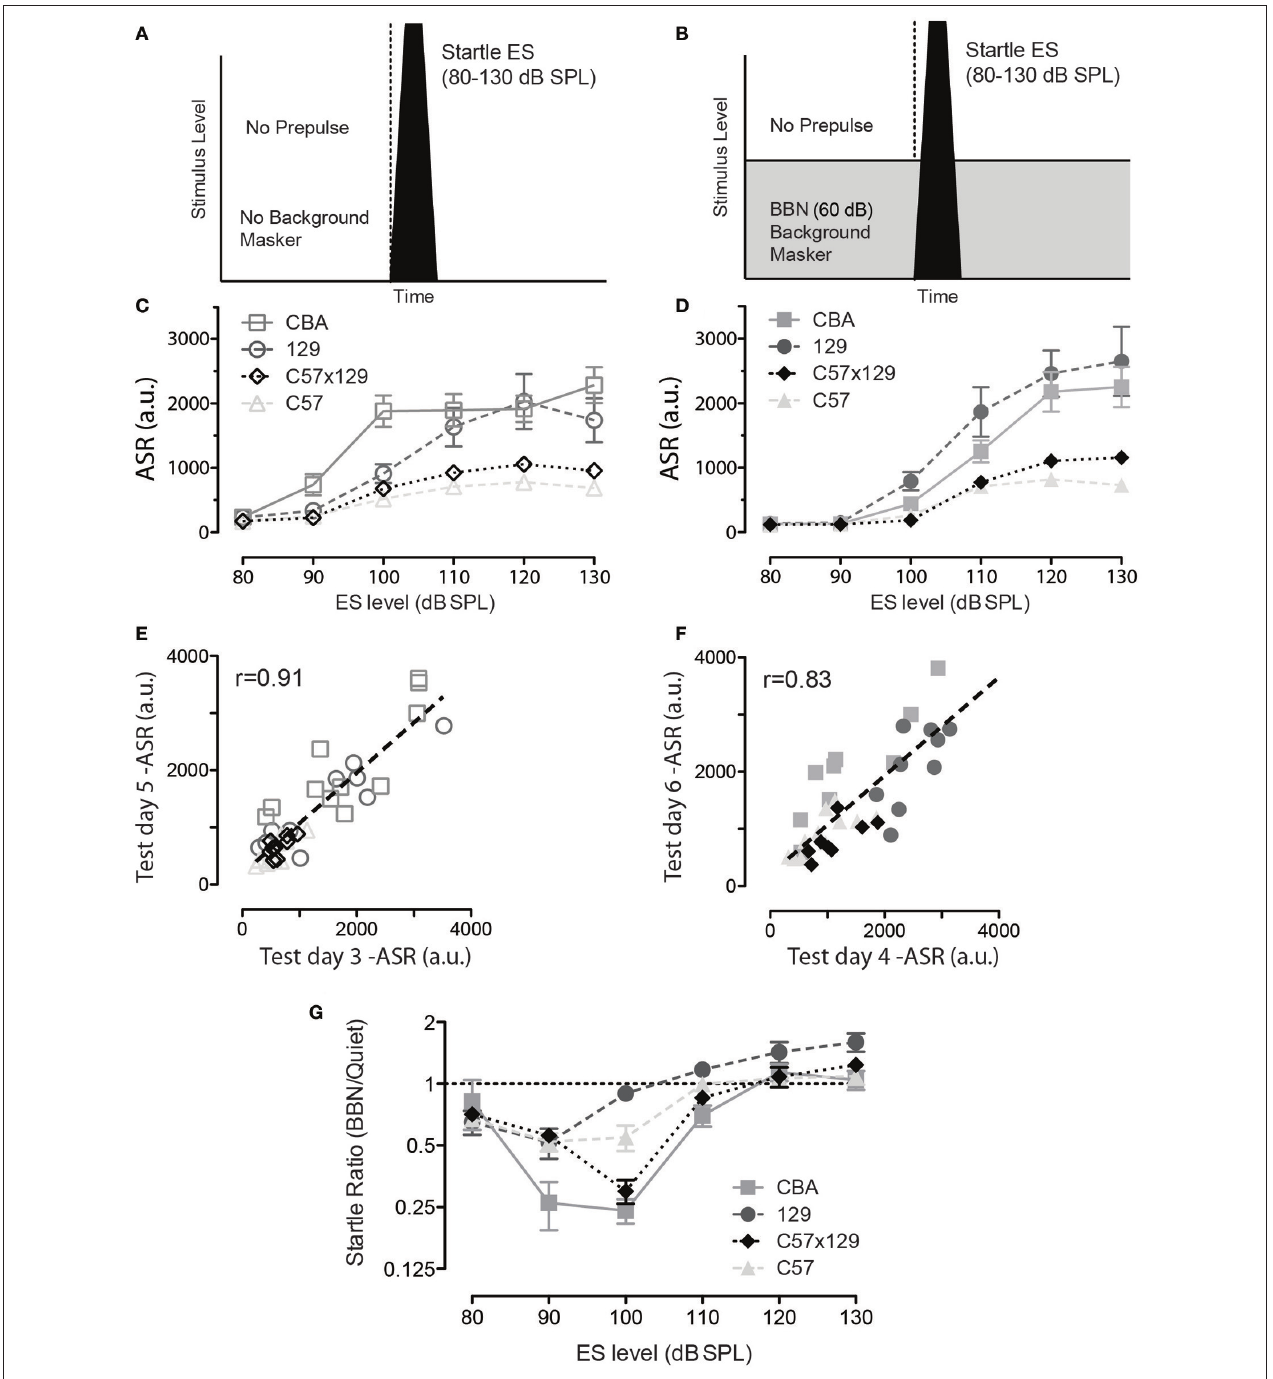
FIGURE 1 | A robust acoustic startle response (ASR) is present in all mouse strains tested, yet varies by sound level, mouse strain, and background noise. (A) Schematic of startle stimulus presented in otherwise quiet background conditions. (B) Schematic of startle stimulus embedded in continuous 60 dB SPL broadband background noise. (C) For each of the four mouse strains tested, the ASR increases with sound level from 80 to 120 dB SPL with near maximal startle elicited in each strain by 120 dB SPL stimulus levels. (D) For each of the four mouse strains tested, at low startle levels, the ASR is reduced compared to when it is delivered in quiet, likely by sensory masking of the startle sound by the background noise; CBA n = 12 animals; 129 n = 12 animals; c57 × 120 n = 12 animals; c57 n = 12 animals. At higher sound levels the ASR increases. (E,F) There is high test/retest reliability for individual mice for both the ASR in quiet (E) and for the ASR in background noise (F) , while there may be variability within and between strains. (G) A new metric, the ASR ratio (BBN/quiet) was computed to compare the ASR in noise to the ASR quiet responses. Note that a startle level (ES) of at least 120 dB is needed to ensure and ASR ratio of 1.0 or higher. Error bars are SEMs.